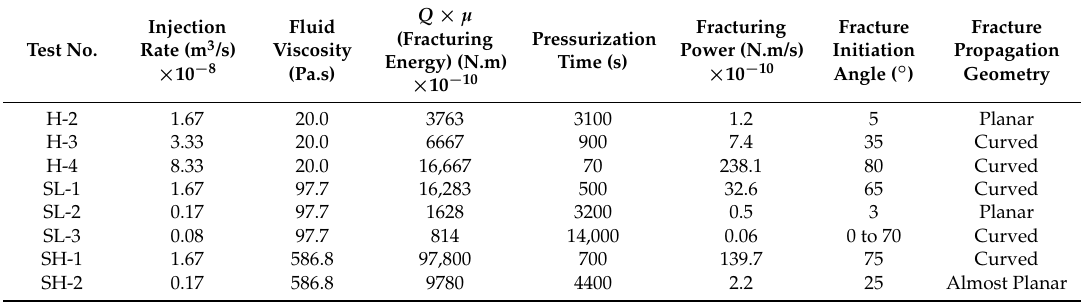
Table 6. Fracturing tests’ energy, pressurization time, power, and fracture geometry characteristics.